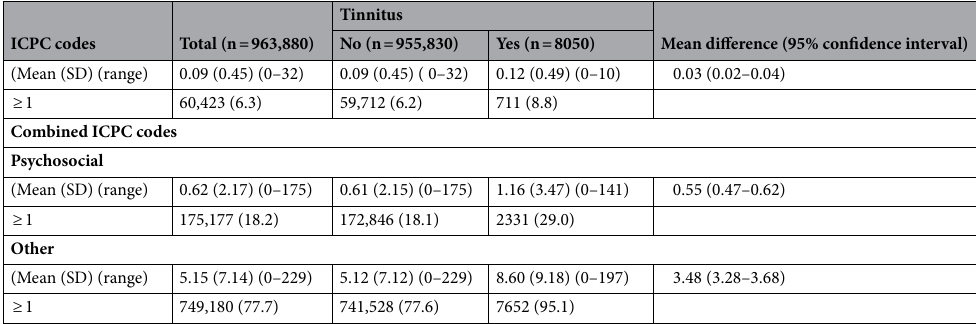
Table 2. Number of different diagnoses per ICPC code. Psychosocial is a combination of ICPC codes: psychological problems and social problems. Other is the combination of all other ICPC codes (exception psychological problems and social problems). a Only calculated for males. b Only calculated for females.